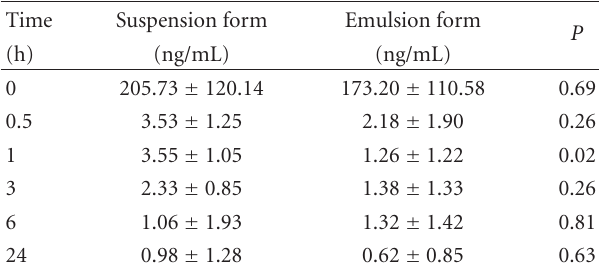
Values are expressed as mean ± SD ( n = 5